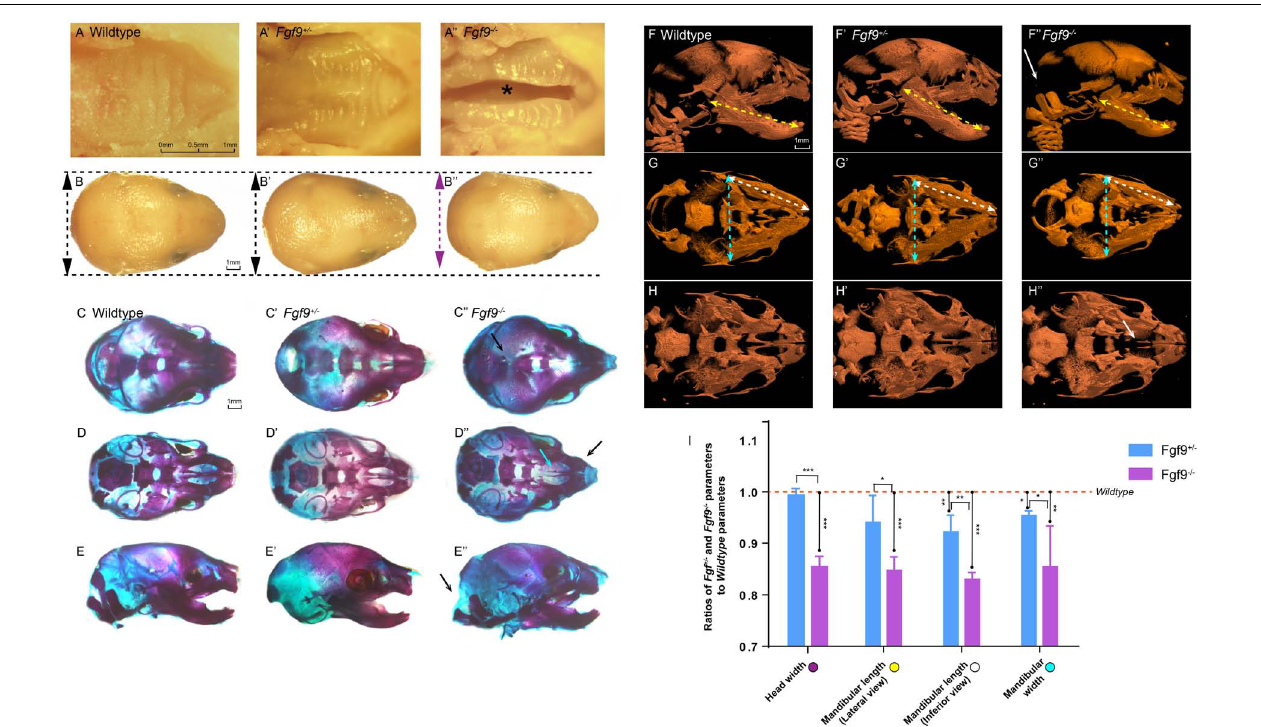
FIGURE 2 | Craniofacial phenotypes of Wildtype , Fgf9 + / − , and Fgf9 − / − mice. Inferior views of (A) Wildtype , (A’) Fgf9 + / − , and (A”) Fgf9 − / − E18.5 embryos. “*” in (A”) indicates cleft secondary palate. Top views of (B) Wildtype , (B’) Fgf9 + / − , and (B”) Fgf9 − / − heads. Purple double-headed arrow in (B”) indicates narrow head width. Black double-headed arrows in (B,B’) indicate normal head widths. Top views of the skeletal staining of (C) Wildtype , (C’) Fgf9 + / − , and (C”) Fgf9 − / − heads. Black arrow in (C”) indicates the premature partial ossification. Inferior views of the skeletal staining of (D) Wildtype , (D’) Fgf9 + / − , and (D”) Fgf9 − / − heads. Blue arrow in (D”) indicates cleft secondary palate. Black arrow in (D”) indicates the abnormal circular tip of the premaxilla. Lateral views of the skeletal staining of (E) Wildtype , (E’) Fgf9 + / − , and (E”) Fgf9 − / − heads. Black arrow in (E”) indicates occipital deficiency. Lateral views of (F) Wildtype , (F’) Fgf9 + / − , and (F”) Fgf9 − / − embryos showing mandibular lengths (yellow double-headed arrows) on micro-CT scans. White arrows in (F”) indicate the occipital deficiency. Inferior views of (G) Wildtype , (G’) Fgf9 + / − , and (G”) Fgf9 − / − embryos showing mandibular widths (blue double-headed arrows) and mandibular lengths (white double-headed arrows) on micro-CT scans. Inferior views of (H) Wildtype , (H’) Fgf9 + / − , and (H”) Fgf9 − / − embryos. White arrow in (H”) indicates the cleft secondary palate. (I) Ratios of Fgf9 + / − and Fgf9 − / − parameters to Wildtype parameters. * P < 0.1, ** P < 0.05, *** P < 0.001.